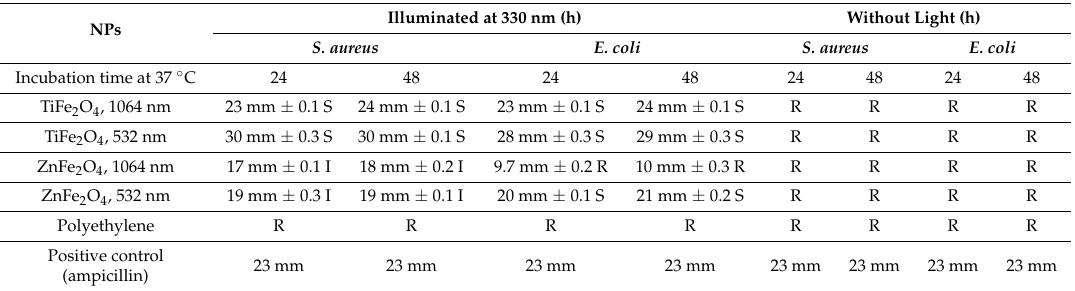
Table 3. Measurements of the inhibition ring according to the Institute of Clinical and Laboratory Standards (CLSI,